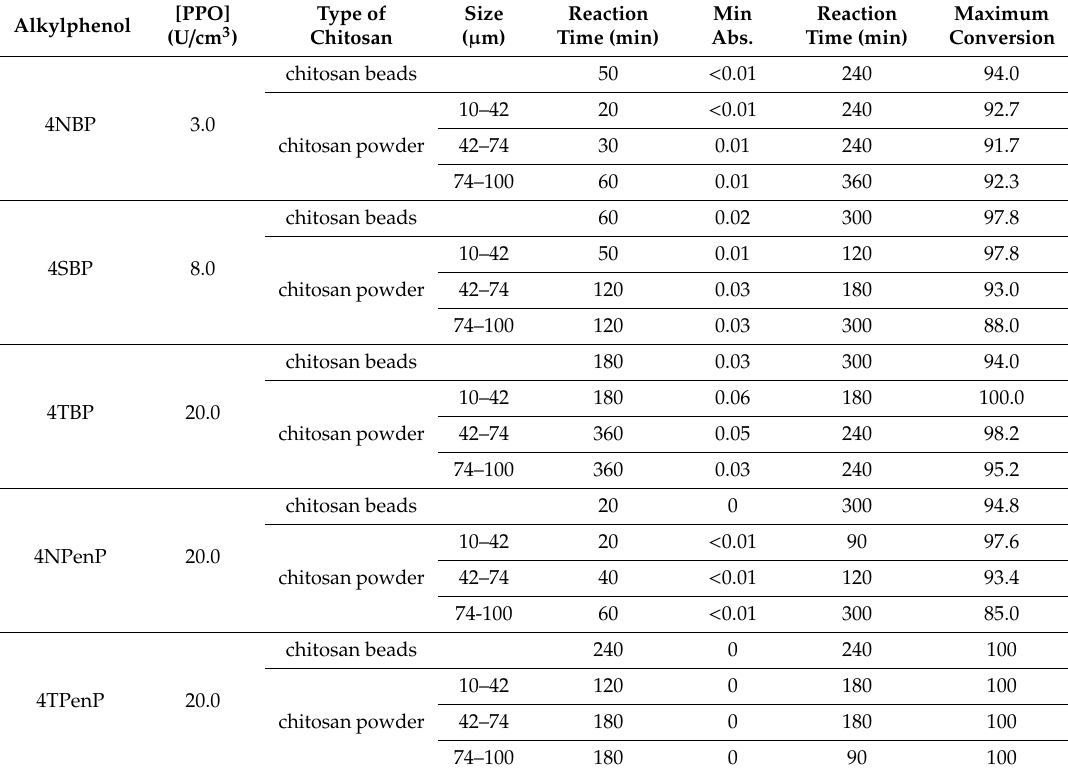
Table 3. Removal of 4NBP, 4SBP, 4TBP, 4NPenP, and 4TPenP through PPO-catalyzed quinone oxidation and subsequent quinone adsorption on chitosan beads and chitosan powders with diameters